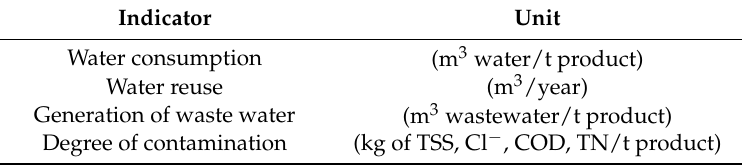
Table 1. Environmental impact indicators for fish canning industries.